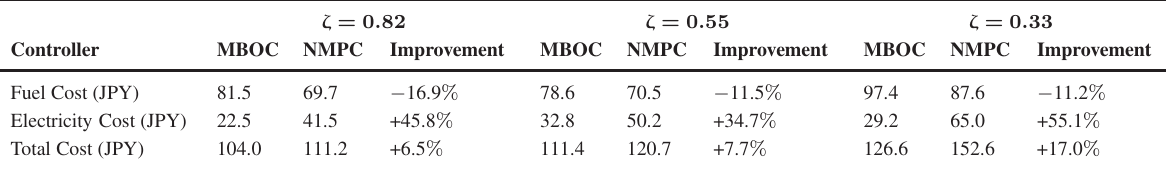
Table 3. Comparison of energy cost for MBOC and NMPC strategies in ζ = 0 . 82 , ζ = 0 . 55 and ζ = 0 . 33 . ζ = 0 . 82 ζ = 0 . 55 ζ = 0 . 33